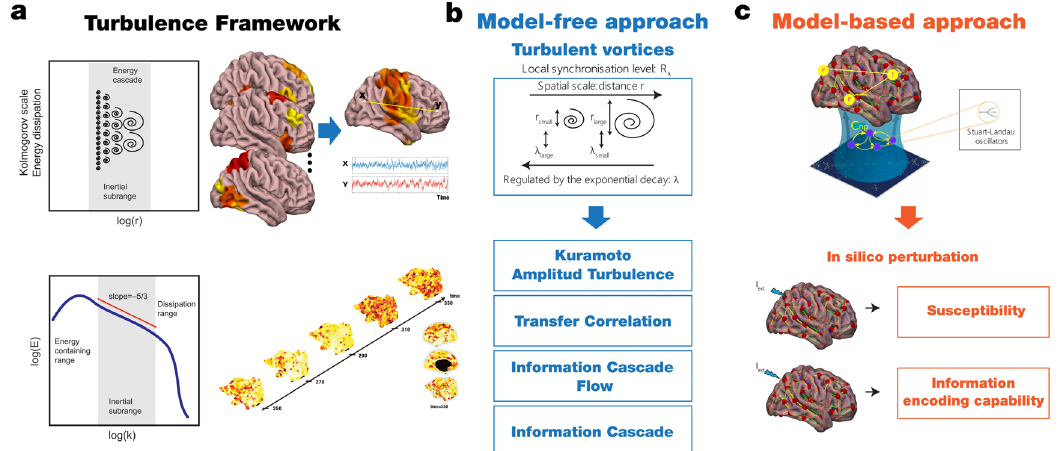
Fig. 1 Overview of framework. a Turbulence in fl uids is one the most common dynamical regime where the mixing motion governs (left panel). The energy cascade, i.e., how the energy travels across scale while dissipated and the statistical properties de fi ned as power laws on the energy levels and structure functions (bottom panel) determine the turbulent behaviour of the fl uid. The analogy between brain activity and Turbulence has been recently demonstrated using resting state data from a large dataset of 1,003 healthy human participants. b Model-free approach. The turbulent behaviour of brain activity is re fl ected in the similarity between the local level of synchronisation, determined by the local Kuramoto order parameter (R) at different scales ( λ ), and vortex with different spatial scales in fl uid dynamics. The spatial scale (r) of the vortex is inversely related with the exponential decay of the local Kuramoto order parameter ( λ ). The turbulence regime also endows the brain with an ef fi cient information cascade measured as the correlation of the local level of synchronisation across scales (Information Cascade Flow). The average across scales of the information cascade fl ow is de fi ned as the Information cascade. The Transfer Correlation quanti fi ed as the correlation of local synchronisation across space at different scales also characterises the brain ’ s information processing. c In the Hopf whole-brain model, the dynamics of each brain area are described through a Stuart Landau non-linear oscillator. The system of local oscillators is connected through the anatomical connectivity to simulate the global dynamics, capable of reproducing statistical observables from fMRI data. We used as structural connectivity the long-range connections (LR) from human diffusion MRI measurements on top of an exponential distance rule (EDR) to fi t the empirical functional connectivity as a function of the Euclidean distance (following the relation between the Kolmogorov ’ s second-order structure-function and the traditional FC). Using whole-brain modelling allows obtaining measures that rise from the in silico perturbative approach. We simulated external stimuli and evaluated the model ’ s reaction for each brain state by quantifying the susceptibility and information capability